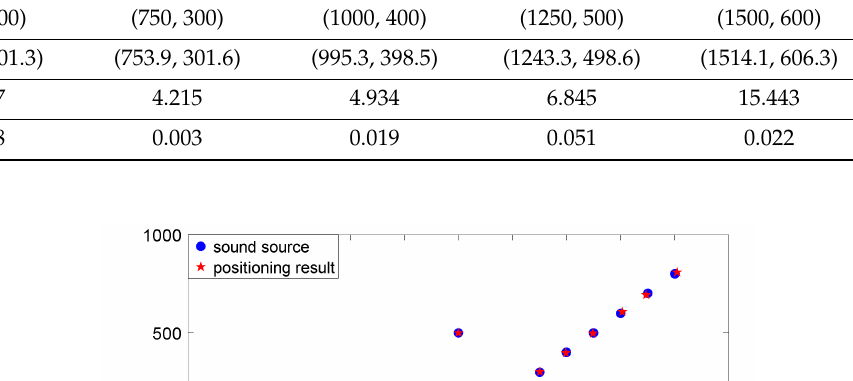
Table 2. The positioning test results with di ff erent-distance at θ = 21.801.